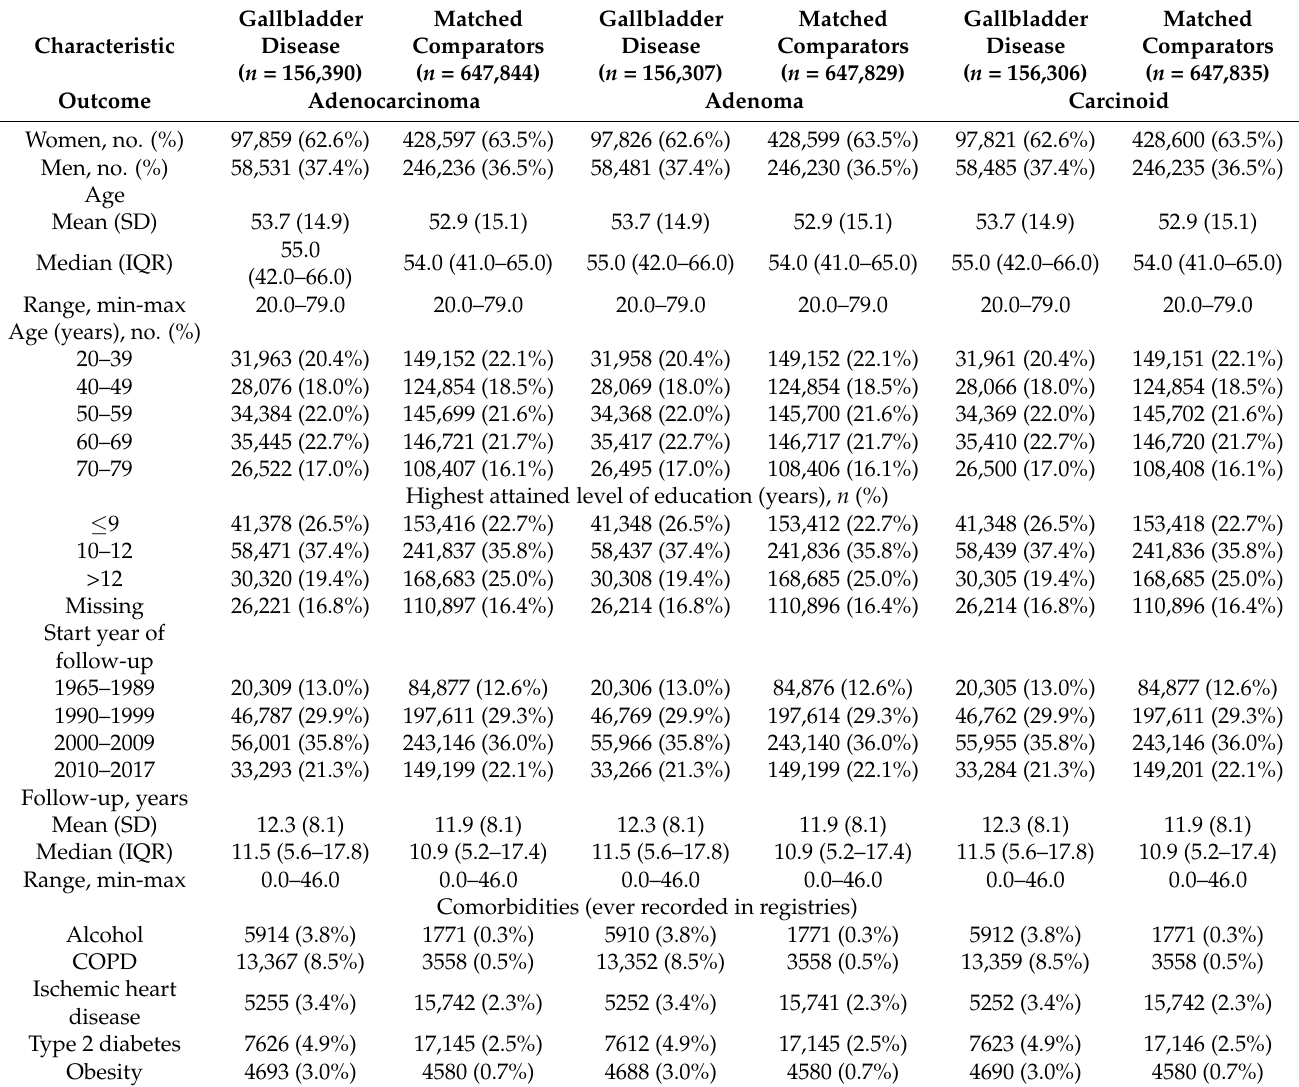
Table 1. Baseline characteristics of study cohort with gallbladder disease and small bowel adeno- carcinoma, adenoma, and carcinoids (populations differ slightly due to exclusion of the outcome of interest prior to study